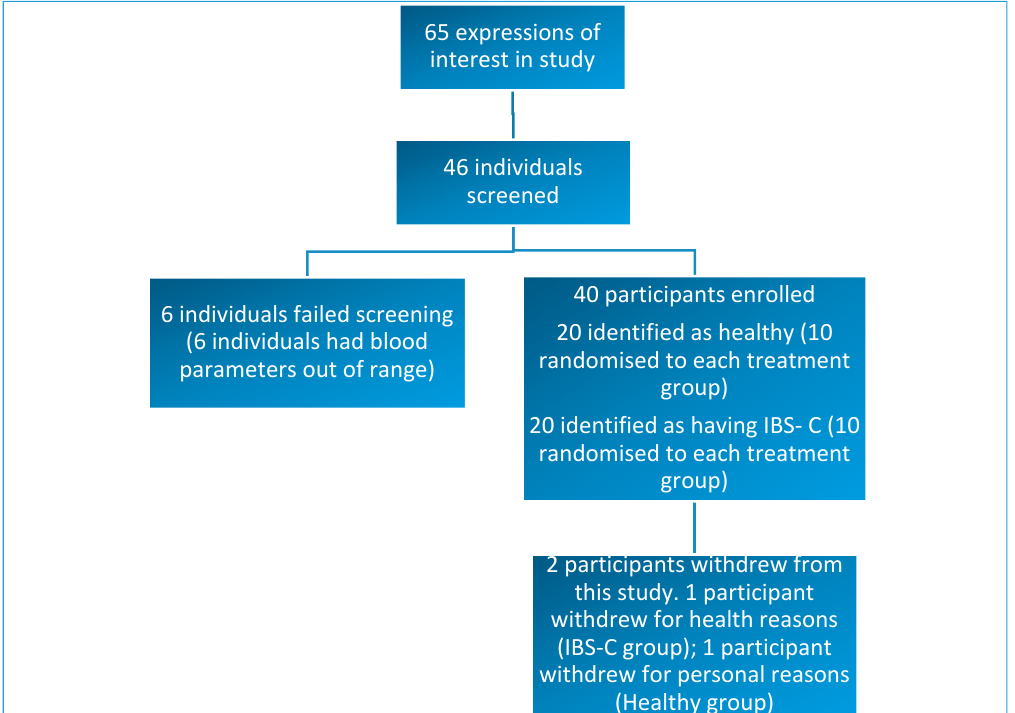
Figure 1. Diagram showing study enrolment and reasons for exclusion or withdrawal from this study.